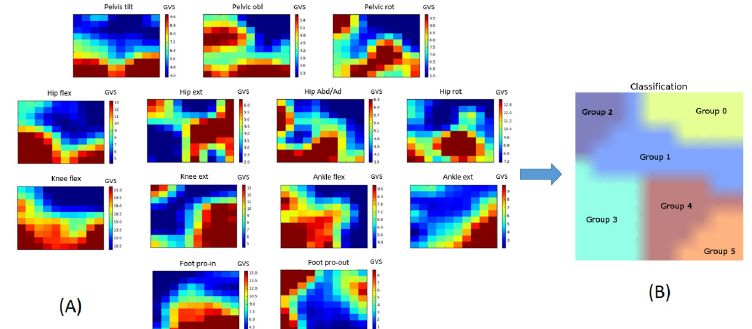
Figure 3. Self-organizing map (SOM) outcome for each gait variable score (GVS) ( A ) and overall SOM map ( B ). Limbs placed close together on the maps had similar gait patterns. In subfigure ( A ), the color scale represents the average GVS of limbs in each unit; blue represents a low GVS and red represents a high GVS. Limbs with low GVSs were usually grouped together, and the same was observed for limbs with high GVSs. Subfigure ( B ) represents the group results after the k-means algorithm was applied. The following abbreviations are used: obl = obliquity, rot = int/ext rotation, flex = flexion, ext = extension, abd = abduction, add = adduction, pro-in = progression inward, and pro-out = progression outward. The Levene test of homogeneity of variance and normality test indicated that population variances in each group were equal and normally distributed. The one-way ANOVA showed a statistically significant difference between groups for each dependent variable (GVS score). Pairwise comparisons of the gait variable score (GVS) distribution are displayed for the pelvis (Figure 4), hip